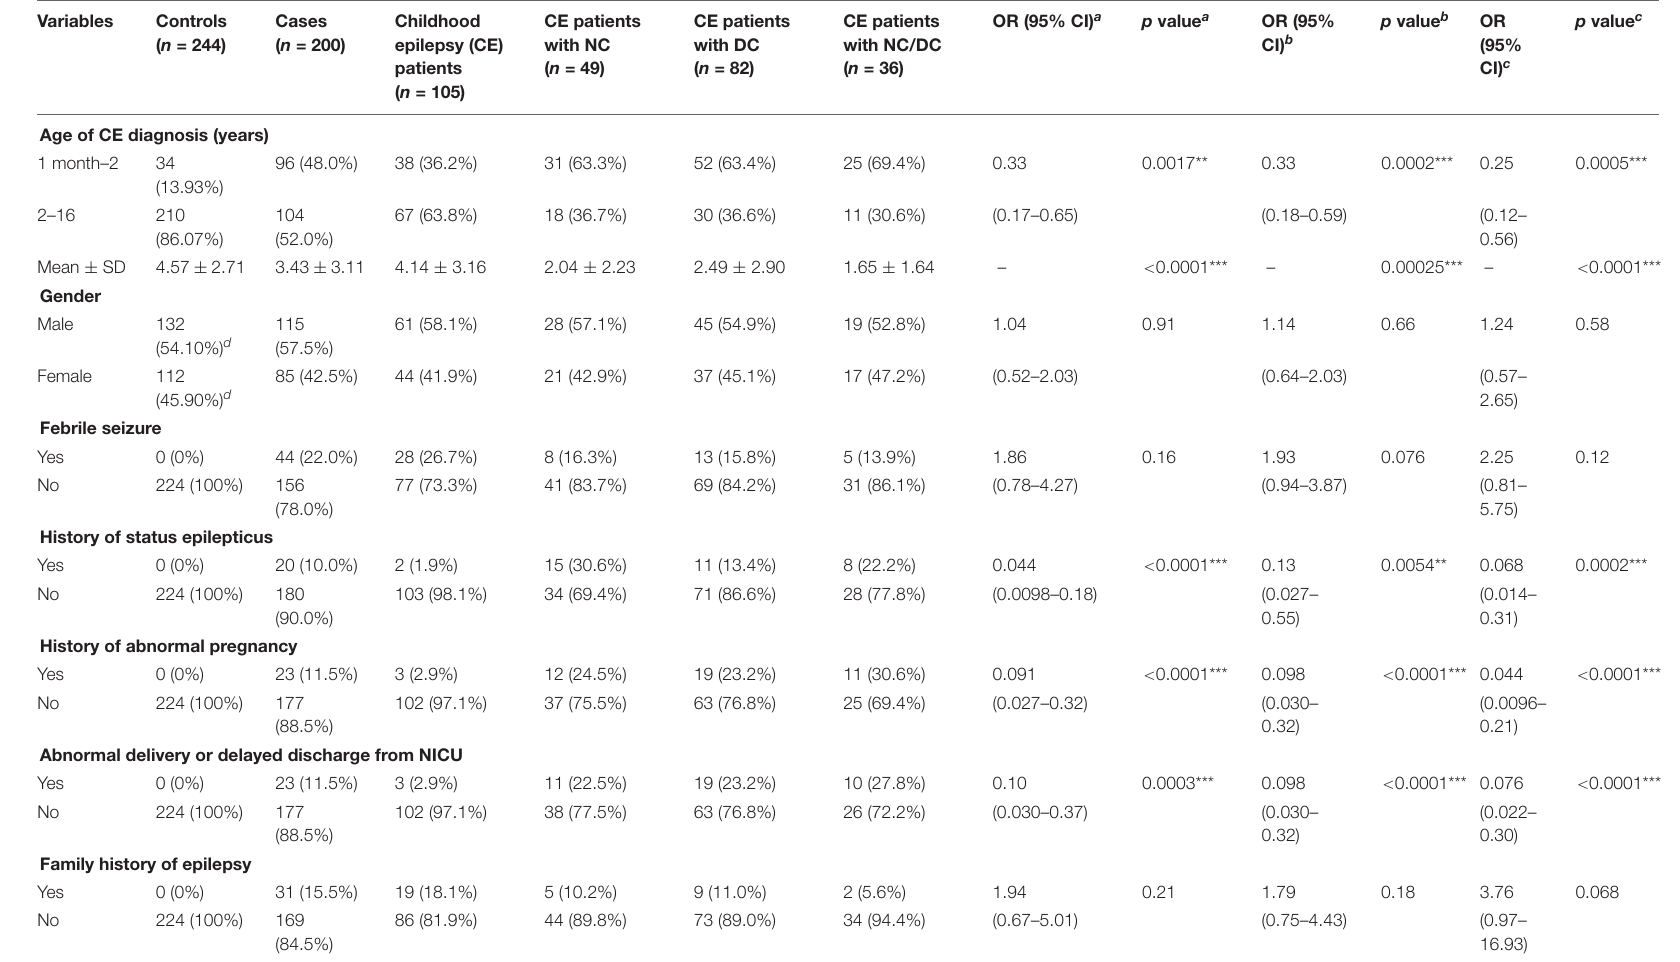
TABLE 1 | Clinical characteristics of children with epilepsy in this